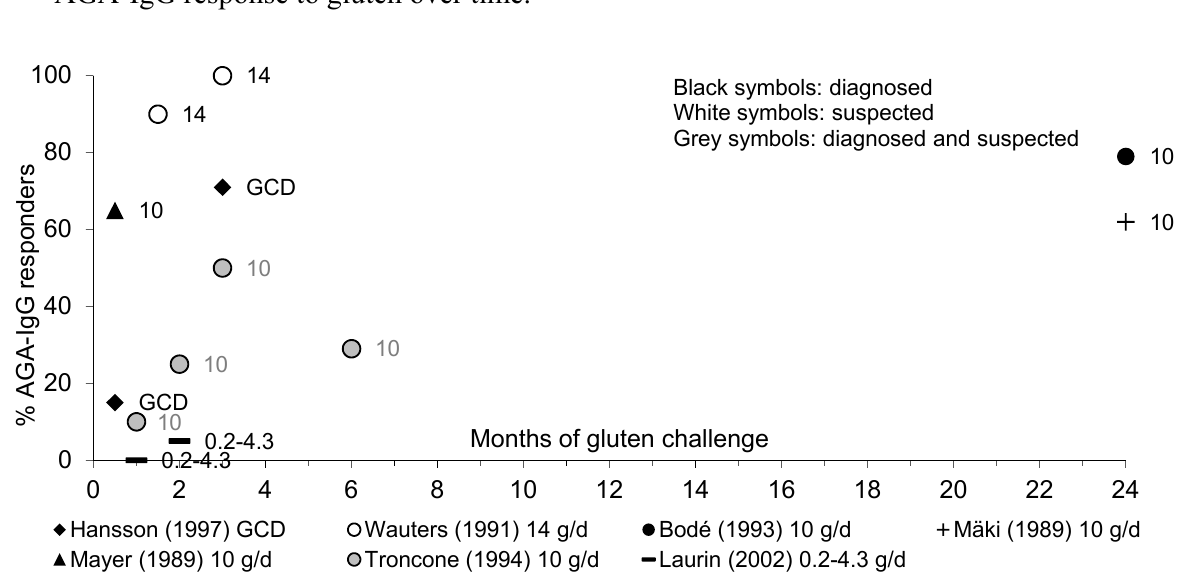
Figure 2. Percentage of pediatric patients with diagnosed or suspected CD showing an AGA-IgG response to gluten over